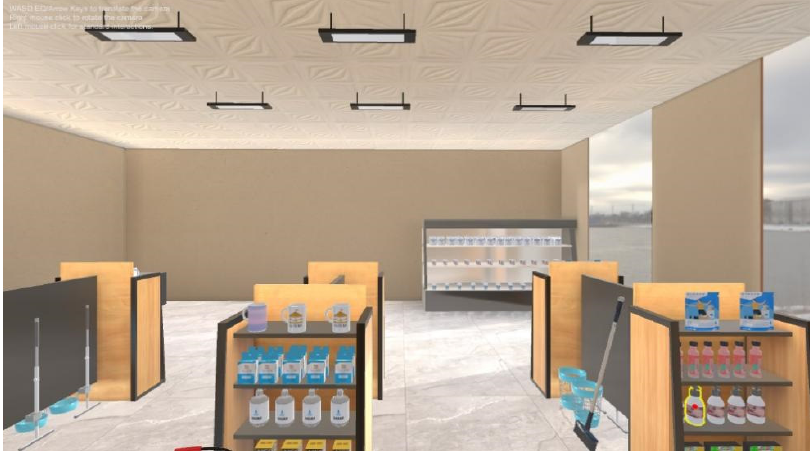
Figure 7. A virtual reality shop developed by Unity3D for future integration into the Metaverse.